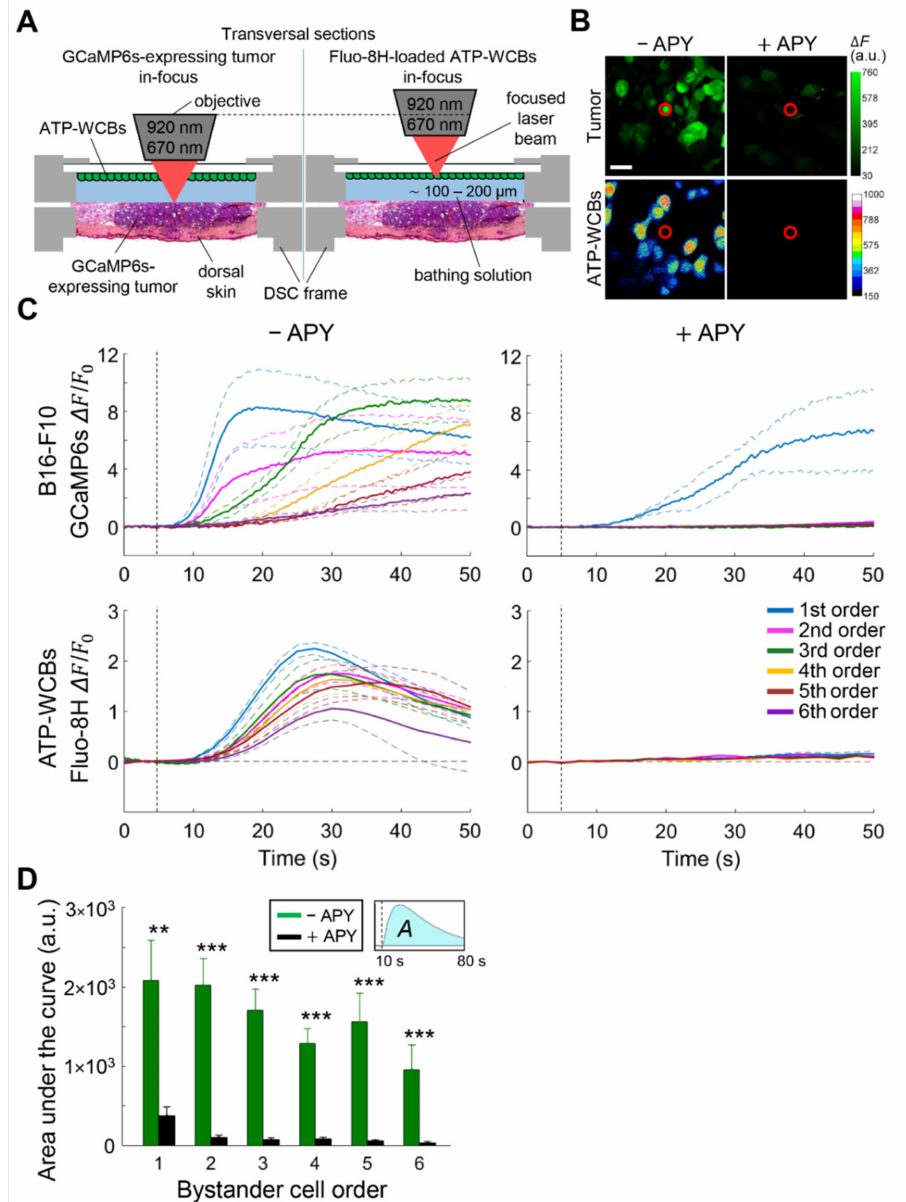
Figure 3. Whole-cell biosensors for adenosine triphosphate (ATP) detection (ATP-WCBs) are activated by extracellular ATP released during the propagation of calcium (Ca 2+ ) waves induced by focal photodynamic therapy (fPDT) in the dorsal skinfold chamber (DSC). ( A ) Schematic representation of the multiphoton microscope objective lens oscillating between two focal planes for real-time detection of ATP release during fPDT stimulation (left, GCaMP6s-expressing tumor; right, Fluo-8H-loaded ATP-WCBs); ( B ) Representative back-projections of ∆ F = F − F 0 (with F 0 pre-stimulus value) frames acquired from tumor (top) and ATP-WCBs (bottom) during fPDT stimulation in the absence of apyrase ( − APY, left) or in its presence (+APY, 250 U/mL, right) in Ca 2+ -free extracellular medium (CFEM). Red circles mark the location of the photoactivation laser beam; scale bar: 20 µ m; ( C ) Average Ca 2+ responses of bystander melanoma cells (top) and ATP-WCBs (bottom) to fPDT before (left) and after (right) addition of APY to the extracellular medium; ∆ F / F 0 signals [mean (solid lines) ± standard error of the mean (s.e.m., dashed lines)] are shown for each bystander cell order. Results are representatives of n ≥ 3 experiments performed in 2 tumors. Vertical dashed lines mark the onset of laser irradiation ( t = 5 s); ( D ) Effect of APY on the amplitudes of fPDT-induced Ca 2+ waves in CFEM supplemented with 5 mM of EGTA; the histogram shows the area under GCaMP6s ∆ F / F 0 signals ( A , see inset) computed for each bystander cell order in the absence of APY ( − APY, green bars, also shown in Figures 1C and 2A) or in its presence (+APY, black bars); data (mean ± s.e.m.) were pooled from n ≥ 6 experiments in at least 2 different melanomas for each condition; a.u., arbitrary units; **, p < 0.01; ***, p < 0.001; the Mann-Whitney U